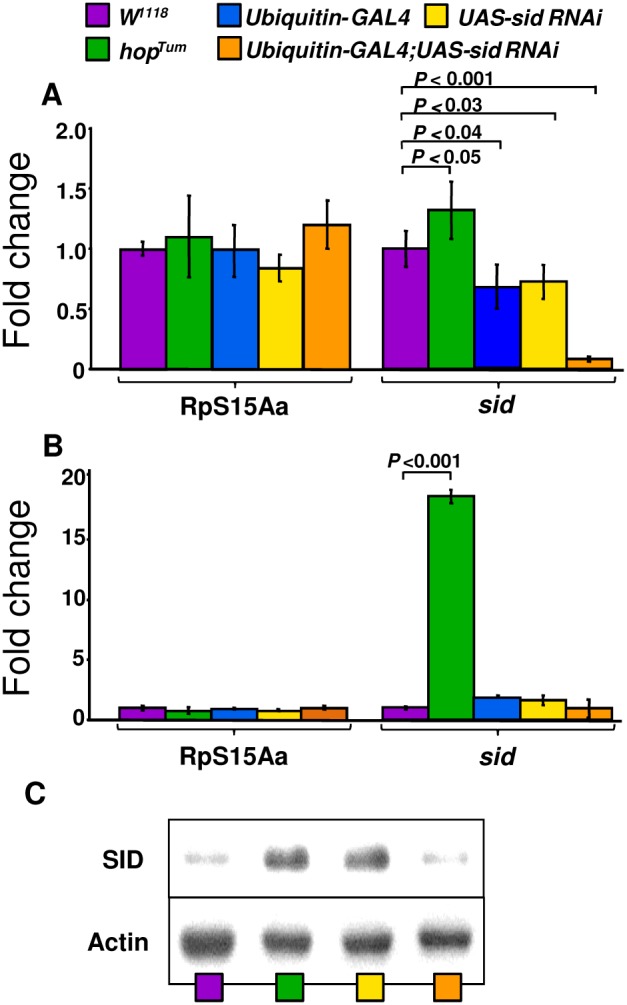
Expression profile of sid in the larval fat body and adult flies.(A) Expression of sid was analyzed by qRT-PCR in control flies W1118 as well as the hopTum mutant line and two transgenic fly lines, UAS-sid RNAi and Ubiquitin-GAL4;UAS-sid RNAi. Expression of sid in each sample was normalized to the expression of the ubiquitously expressed ribosomal RpS15Aa (CG2033) gene. Expression levels for both RpS15Aa and sid were calibrated to the wild type control levels, which were then assigned an arbitrary value of one, for each gene. Fold expression (numbers over bars) was determined by dividing the mean value derived from the W1118 control flies by the mean value obtained from other fly lines (ie., hopTum sid value over W1118 sid value). Values were rounded up to the next decimal. Arrows represent fold up-regulation (up) or down-regulation (down). Each qRT-PCR experiment was performed in triplicate using RNA samples (cDNA) from the different genotypes. Bars represent the standard deviation from the mean. (C) Detection of SID protein by western blot analysis. Crude extracts from adult female flies were separated by SDS-PAGE, transferred to PVDF membranes and hybridized with rabbit anti- SID peptide antibodies as described in Materials and Methods.